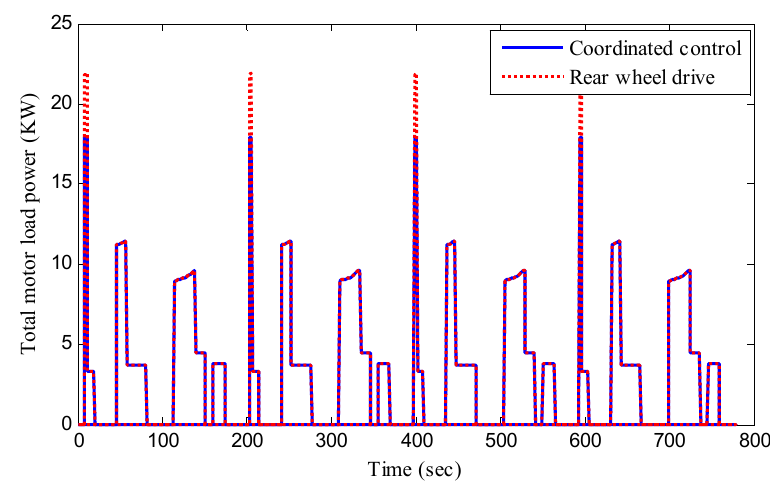
Figure 22. Motor e ffi ciency in case study 3. Figure 22. Motor efficiency in case study 3. Figure 22. Motor efficiency in case study 3.